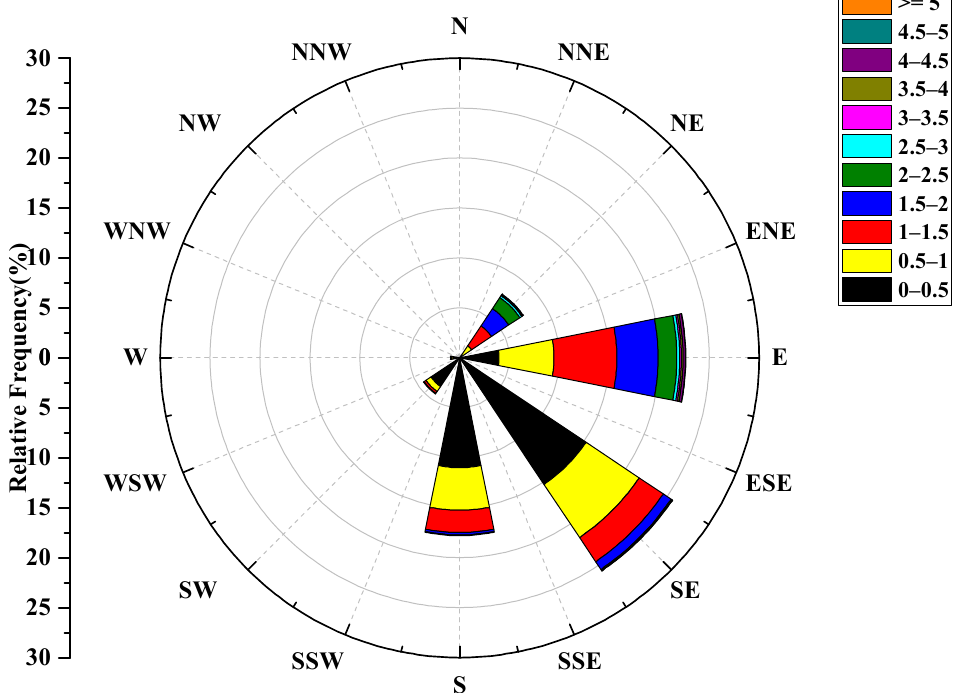
Figure 3. Wind speed and direction rises at the NYNU site in Nanyang from 19 November 2021 to 19 March 2022.